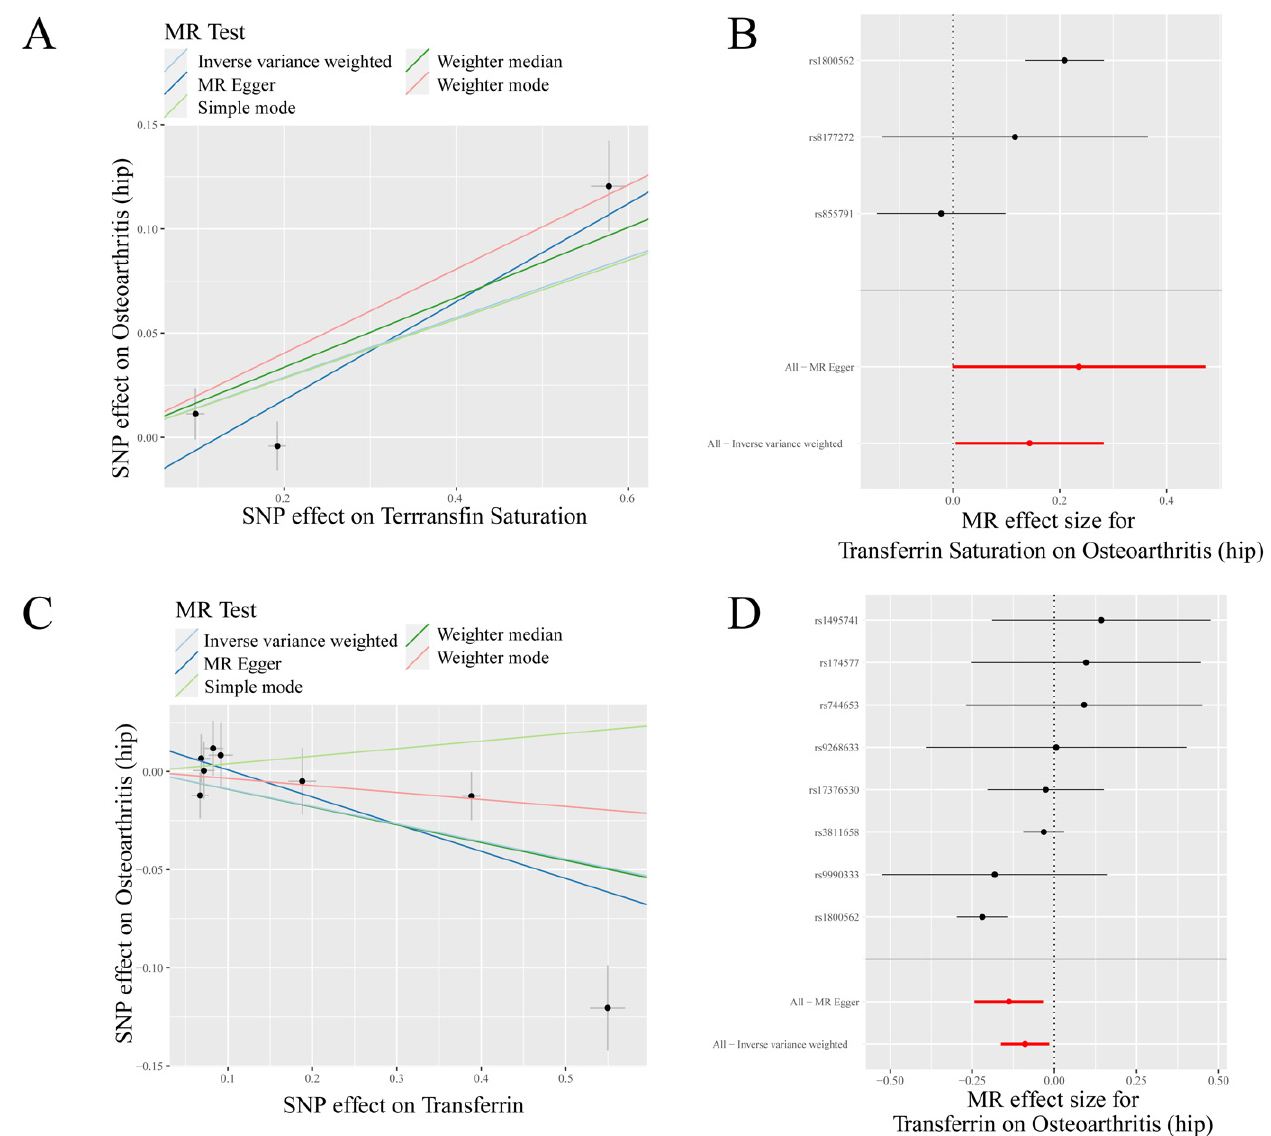
Figure 2. MR results of transferrin saturation, transferrin and hip osteoarthritis (HOA): ( A ) scatter plot of genetic correlations of transferrin saturation and HOA using different MR methods. The slopes of line represent the causal effect of each method, respectively; ( B ) forest plot of the causal effects of transferrin saturation associated SNPs on HOA; ( C ) scatter plot of genetic correlations of transferrin and HOA using different MR methods. The slopes of line represent the causal effect of each method, respectively; and ( D ) forest plot of the causal effects of transferrin associated SNPs on HOA. ( B ): The red and black dot/bar indicate the causal estimate of transferrin saturation level on risk of patients with HOA. ( D ): The red and black dot/bar indicate the causal estimate of transferrin level on risk of patients with HOA.